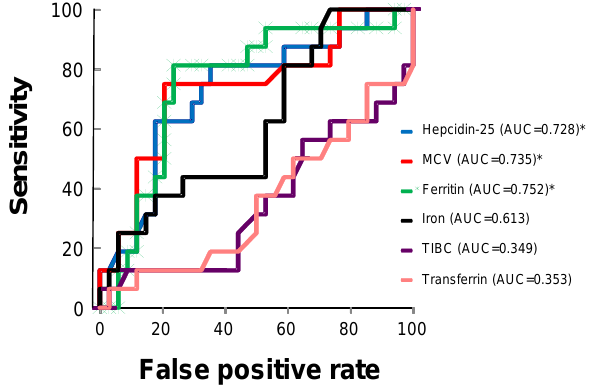
Figure 3. A ROC curve analysis for the evaluation of variables predictive of the response to OIT.